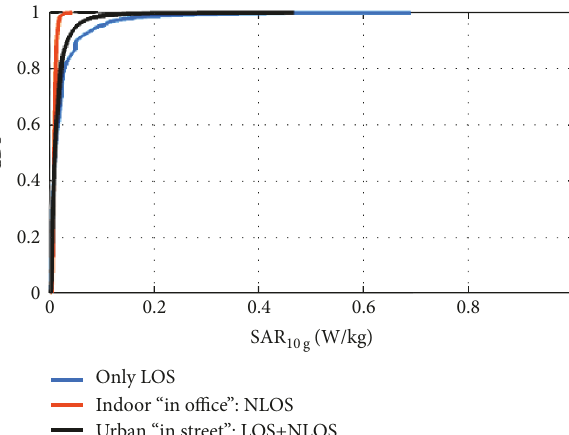
Figure 7: Comparison between empirical distribution of the input power delivered to the mobile phone during pure NLOS scenario and a log-normal distribution.